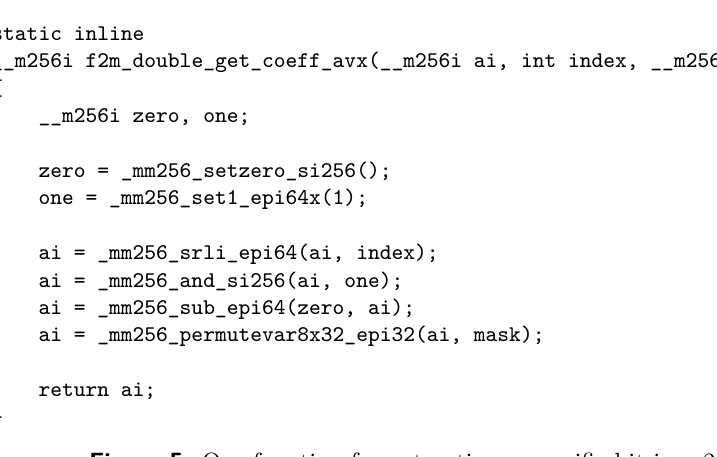
Figure 5: Our function for extracting a specific bit in a 256-bit